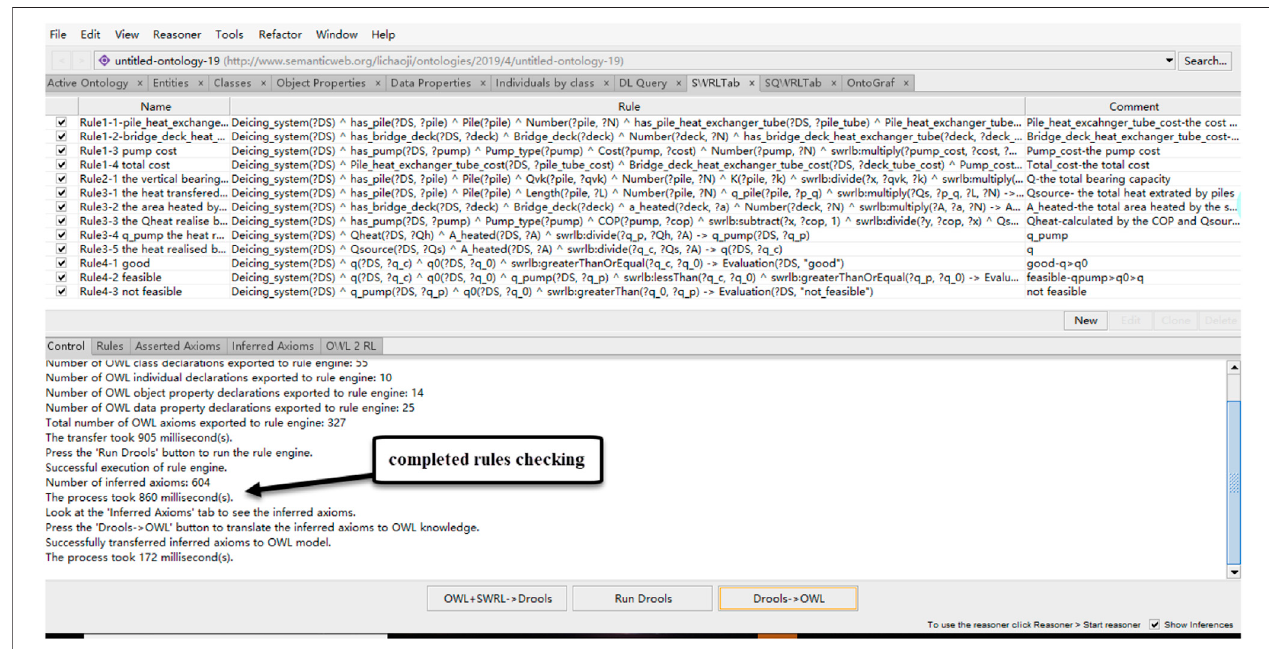
FIGURE 8 | The log of running SWRLTab plug-in for the SWRL rules validation.